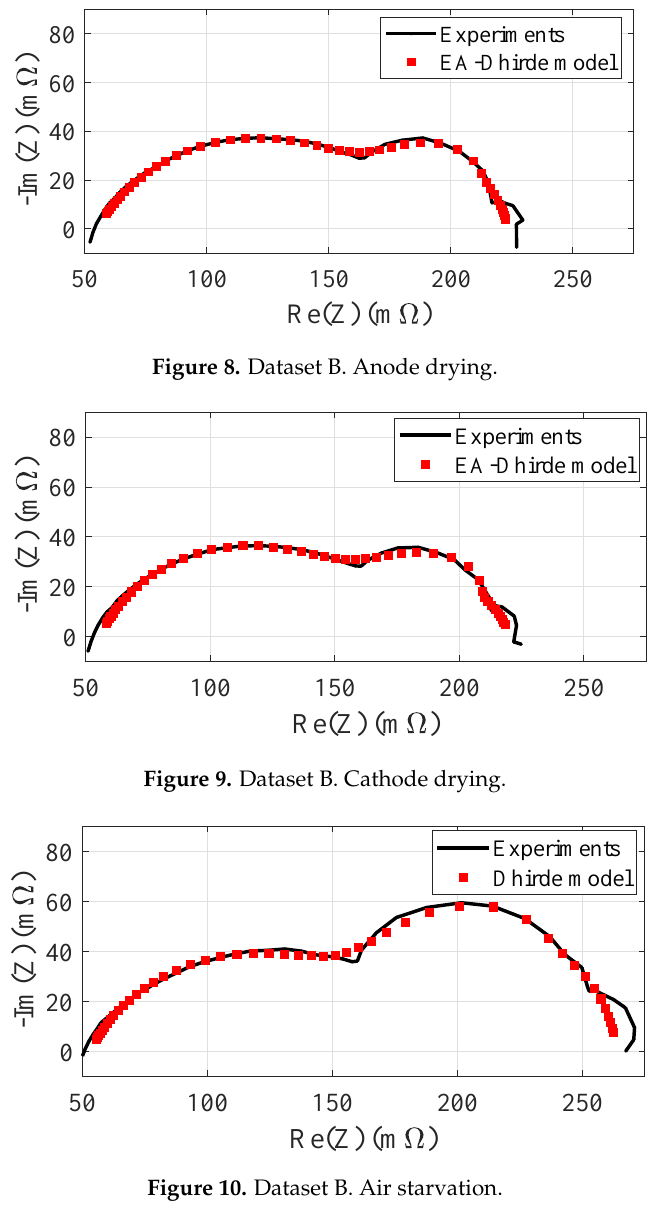
Figure 10. Dataset B. Air